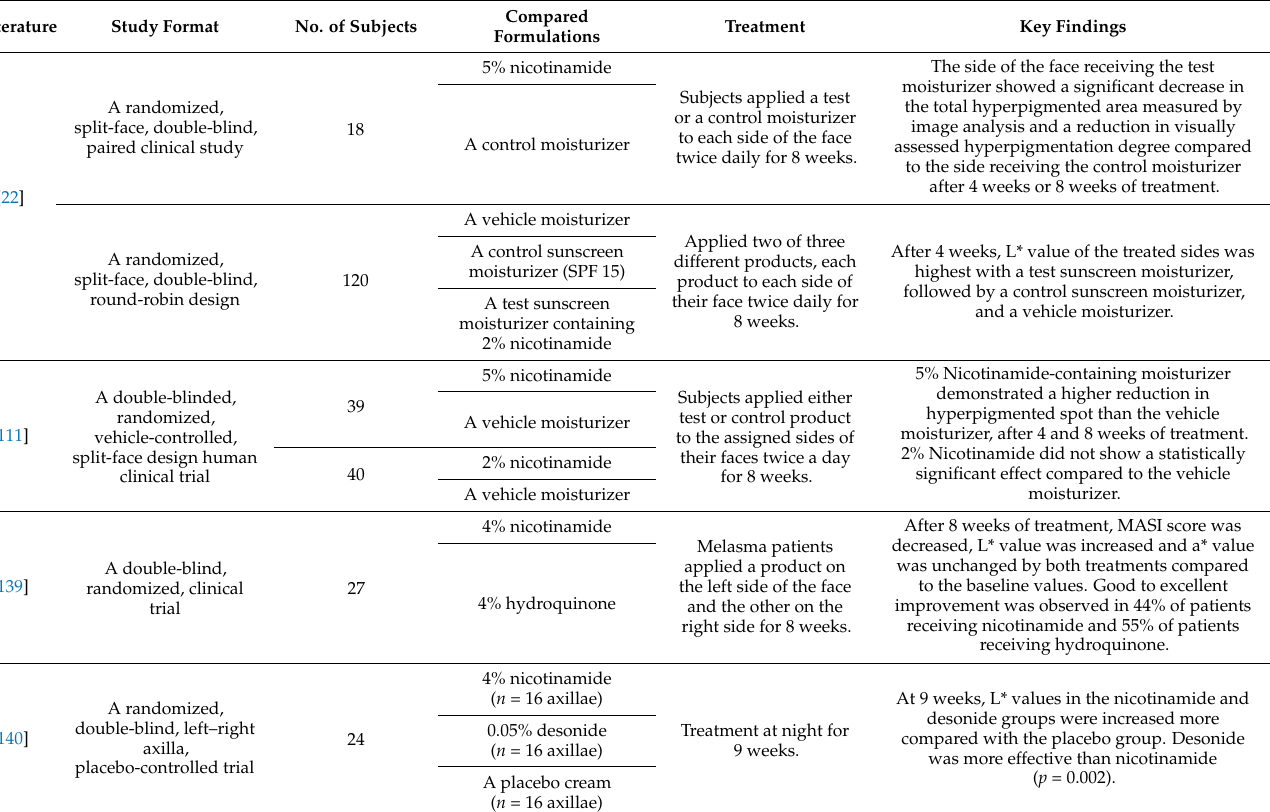
Table 2. Skin-lightening efficacy of cosmeceuticals containing